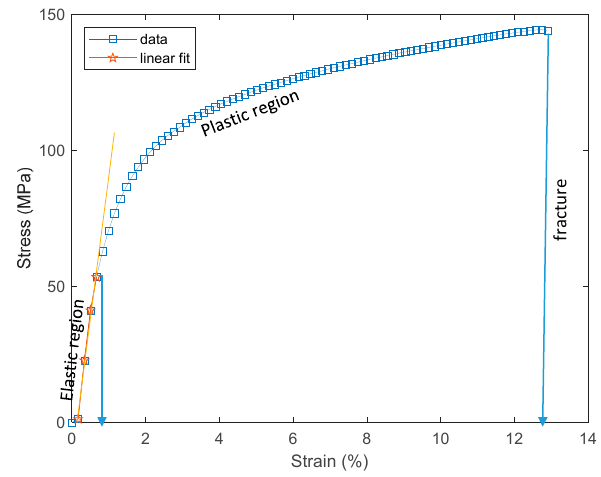
Figure 4. Stress–strain curve of the FPCB test sample.